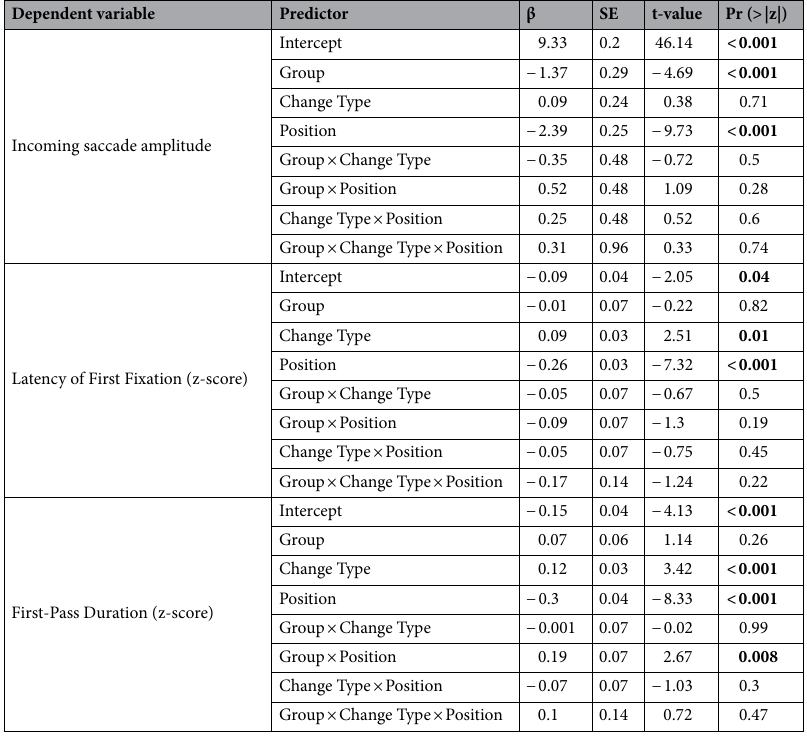
Table 4. Linear mixed effects model output for the eye-tracking measures during recognition (correct trials only) on the Current Location and Past Location, focusing on the conditions in which the critical object changed position (Both and Location). Predictors centred and standardized entered were: Group (Younger = − 0.5 and Older = 0.5) Change Type (Location = − 0.5 and Both = 0.5), Position (Current Location = − 0.5 and Past Location = 0.5). We report the β , the standard error, the t -value and the p -value. The random effects introduced as intercept were Participants (50) and the unique identifier of Scene item